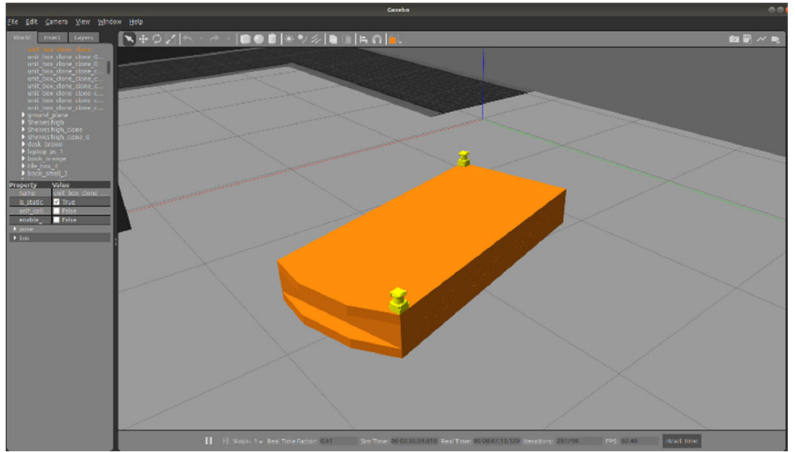
Figure 4. SGV model in